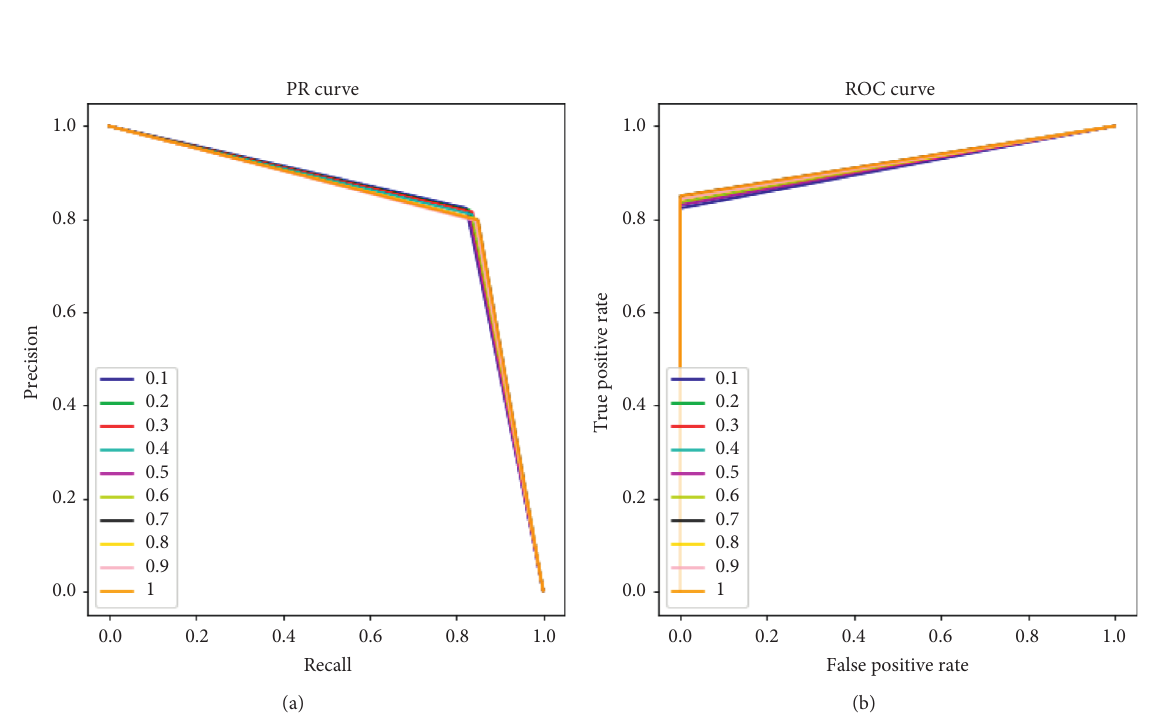
Figure 6: PR curve and ROC curve under different sampling ratios for the kNN-SMOTE-LSTM. (a) PR curve. (b) ROC